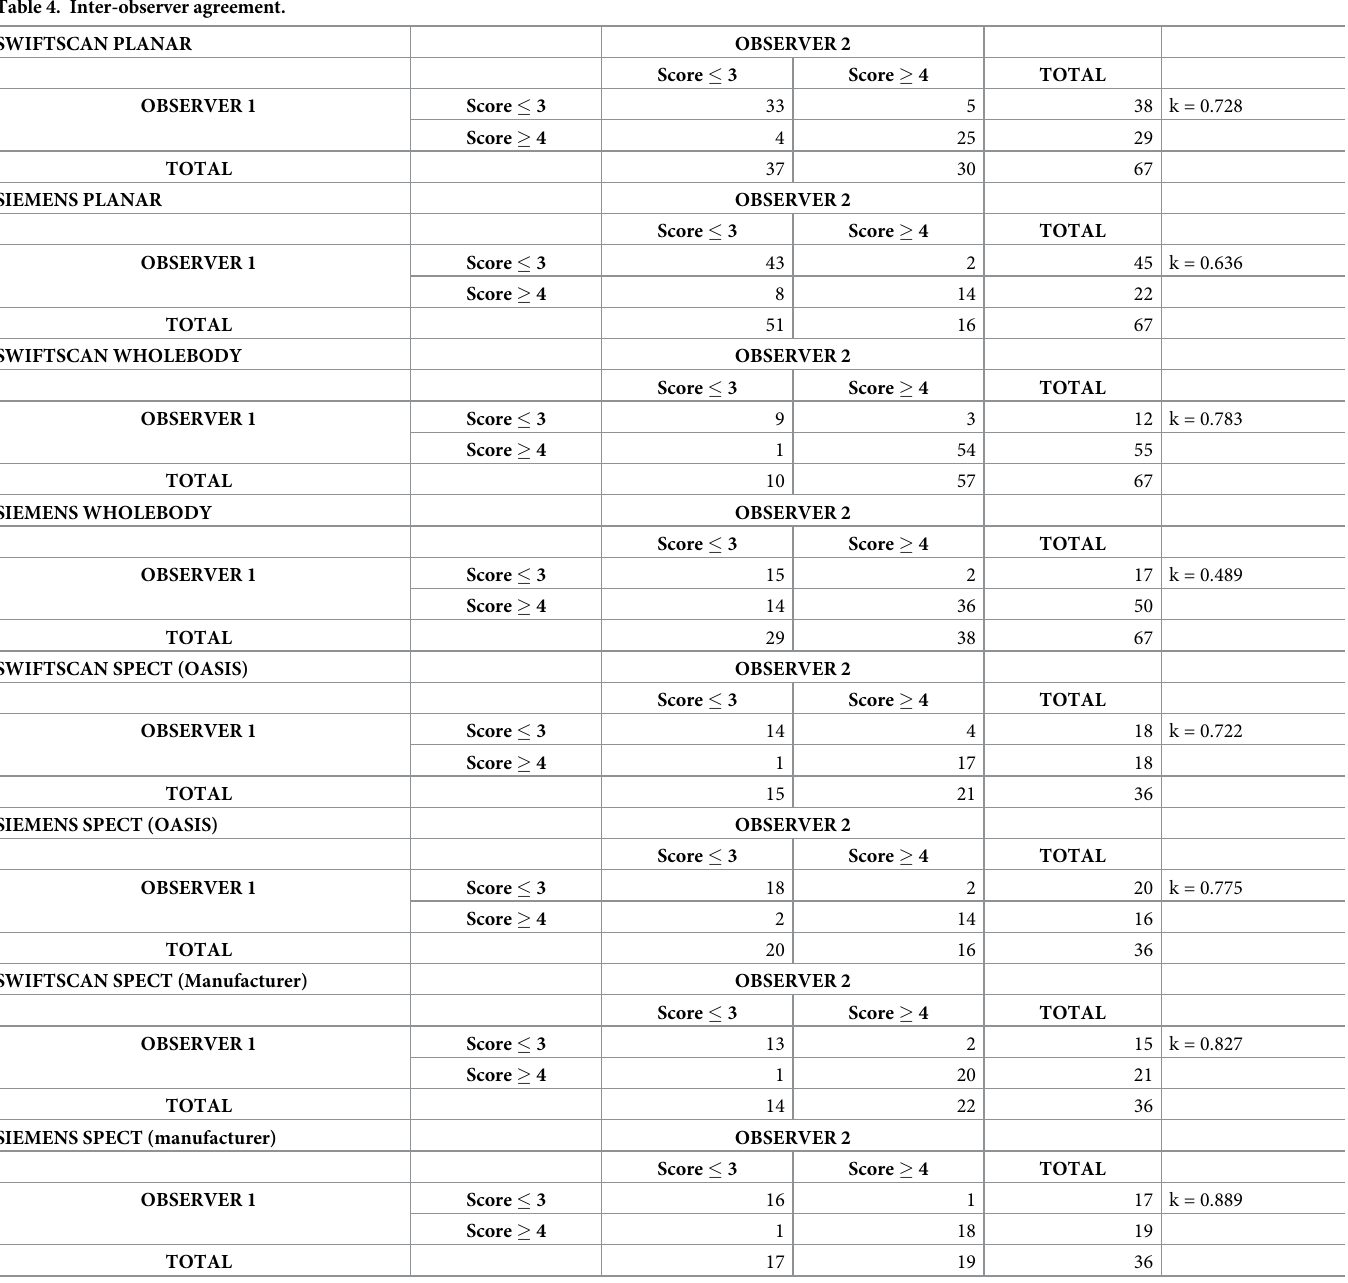
Table 4. Inter-observer